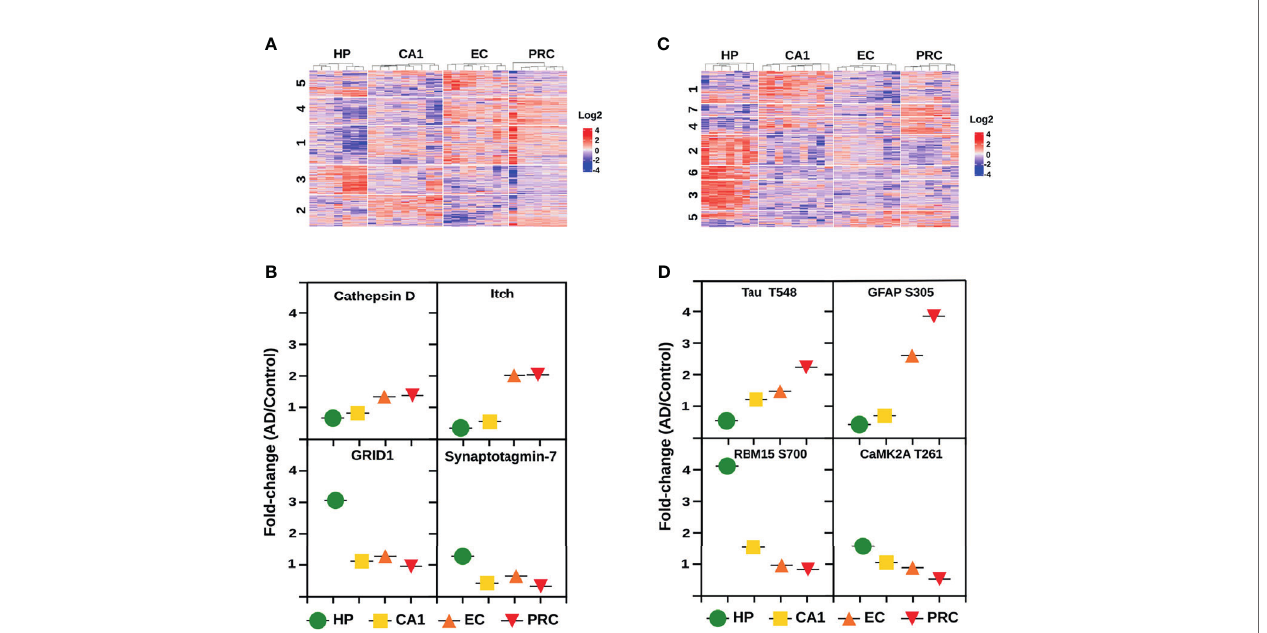
FIGURE 6 | Molecular trajectories across the AD vulnerable areas. (A) Protein clusters from the global proteome analysis with altered log2 fold change (AD/C median) pro fi les across the four brain areas. (B) Log2 fold change pro fi les with increasing and decreasing tendencies across the four AD vulnerable brain areas of 4 representative proteins. Data derived from the global proteome analysis. (C) Phosphopeptide clusters with altered log2 fold changes (AD/C median) across the four brain areas. (D) Log2 fold change pro fi les with increasing and decreasing tendencies across the four AD vulnerable brain areas of 4 representative phosphoproteins. Data derived from the phosphoproteomic